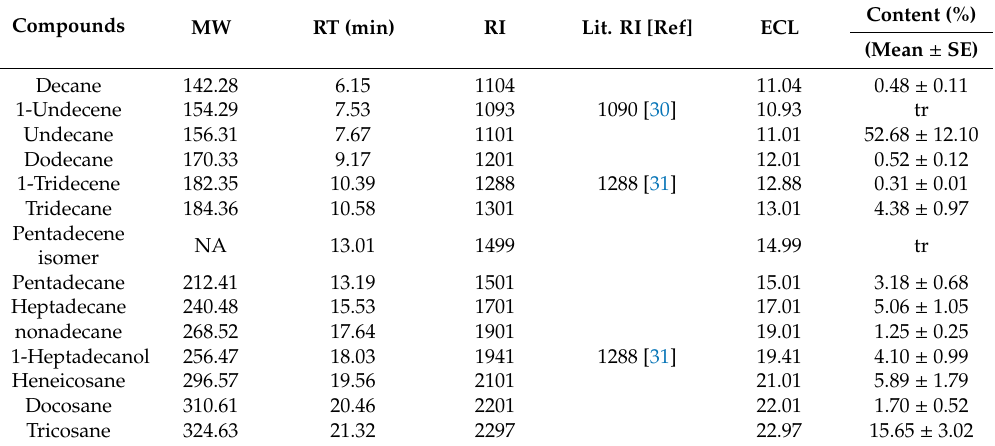
Table 3. Compounds isolated from poison gland of workers of Oecophylla smaragdina.